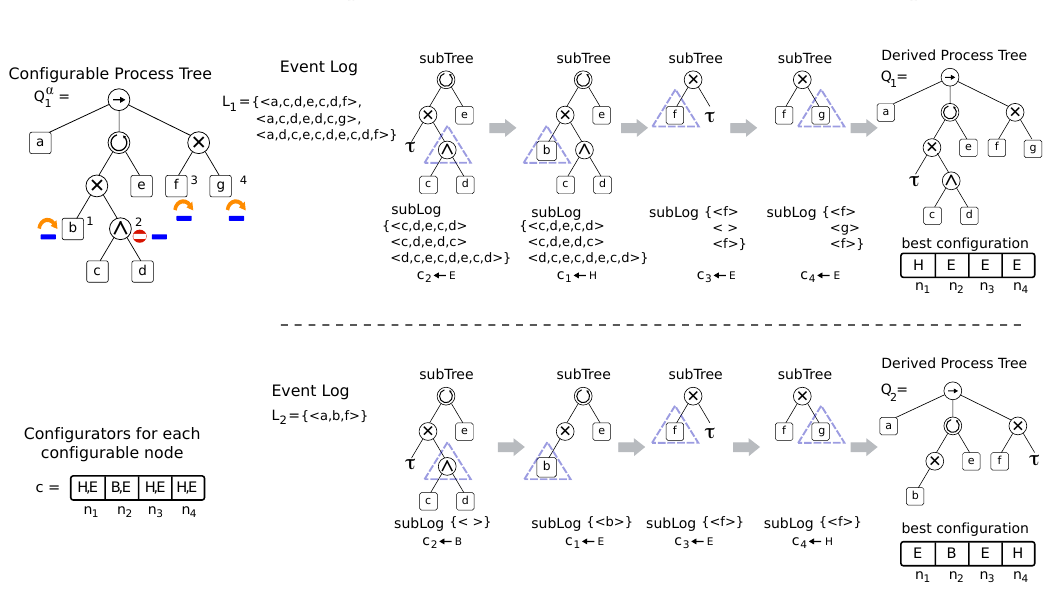
Figure 9. Overview of the greedy strategy to derive a process tree. There are two event log inputs to show different subtree and sub-log scenarios to finally derive a process